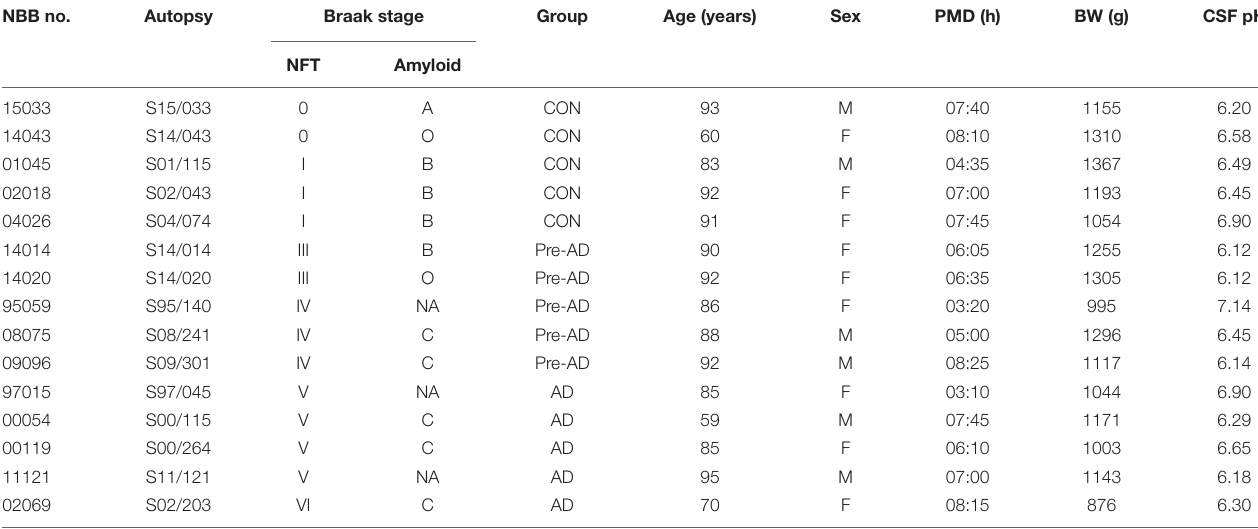
TABLE 1 | Demographic and clinicopathologic information of the samples. NBB